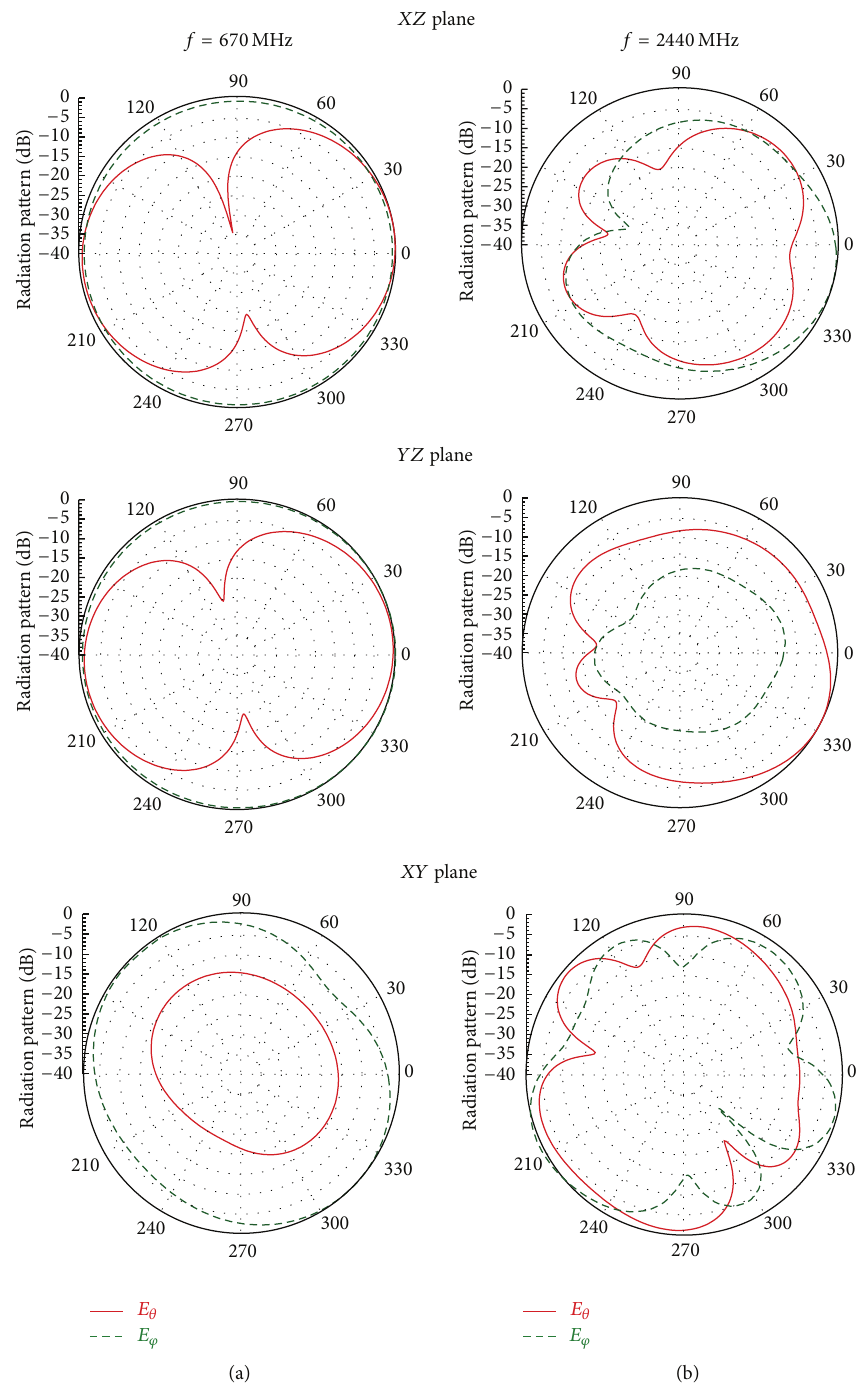
Figure 14: Simulated radiation patterns ( 𝐸 𝜃 and 𝐸 𝜑 components normalized to the electric field amplitude at 𝜃 = 0 ) for the proposed dual- band L-shape PIFA: (a) 670MHz (central frequency for the DVB-T band); (b) 2440 MHz (central frequency for the IEEE 802.11b,g